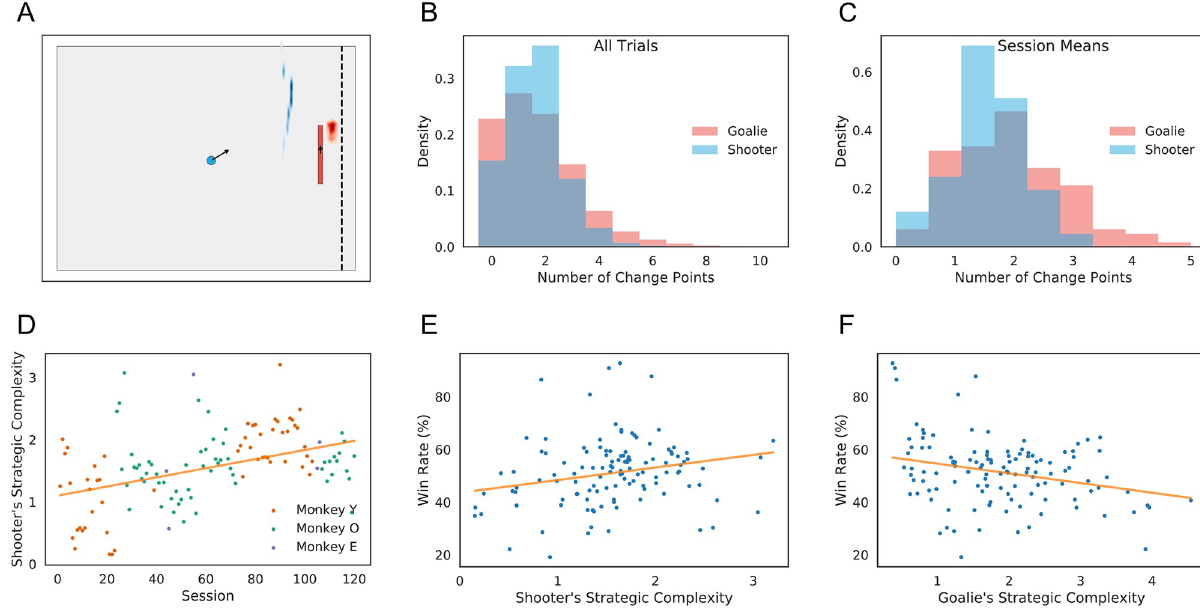
Fig 8. Number of change points as a measure of strategic complexity. A: At a given game state, each player’s energy function (blue, shooter; red, goalie) captures the evolution of his goal in the next time step. Here, the goalie’s energy function is unimodal, while the shooter’s energy function consists of a tightly clustered handful of potential targets. Gray area indicates the visible screen (game area) during the task. White indicates offscreen regions. We use the number of change points in each player’s control signal as a proxy for this complexity. B, C: Histograms of change points for all trials (B) and session means (C) for both players. D: Evolution of strategic complexity across sessions. Over the course of the experiment, the average number of shooters’ change points per trial increased. E, F: Correlation of average number of change points of shooter (E) and goalie (F) with shooter’s win rates. Each dot indicates a single session. Both shooters and goalies benefited from more change